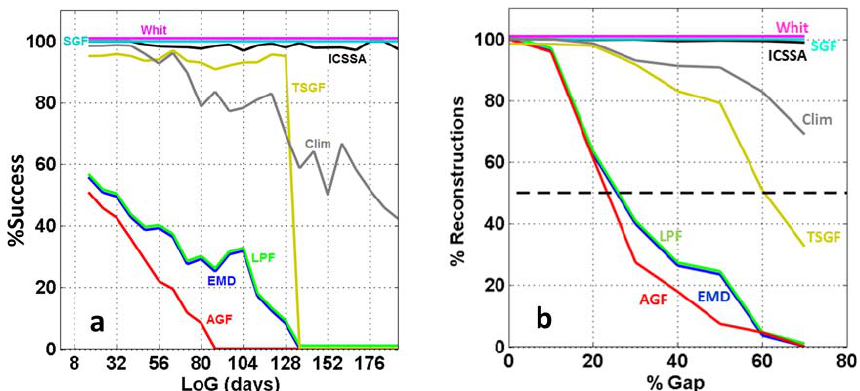
Fig. 6. (a) Fraction of gaps reconstructed (%success) as a function of the length of the gaps (LoG). (b) Fraction of dates reconstructed (%reconstructions) as a function of the %gap. The horizontal dashed line represents the 50% threshold of %reconstructions. The several methods are represented by different colors. Some values were slightly shifted vertically to ease the reading when curves were overlapping.